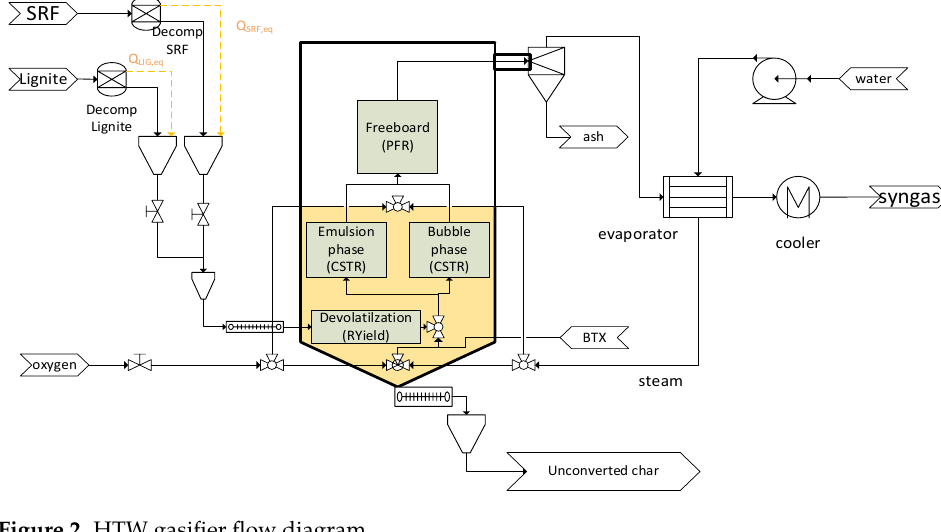
Figure 2. HTW gasifier flow diagram .